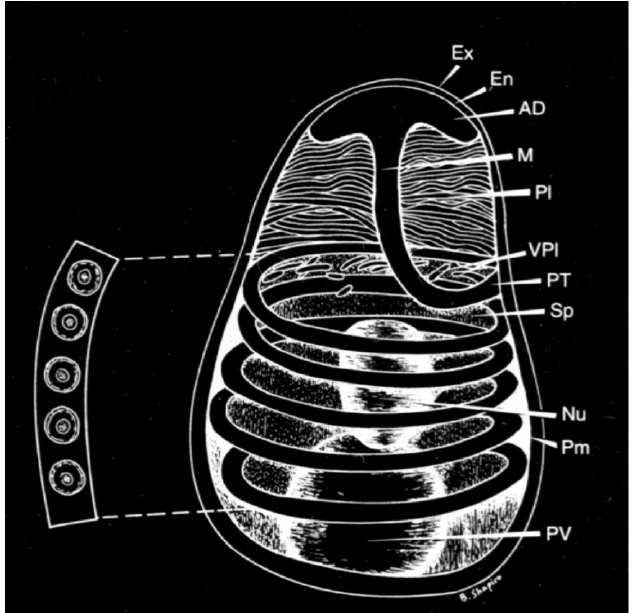
Figure 1. Structure of a spore of Microsporidia. Ex—outer wall of microsporidia spores, En—inner wall of microsporidia spores, AD—top of the spore, M—manubrium, Pl—lamellar polaroplast, VPl—vesicular polaroplast, PT—polar tube, Sp—sporoplasm, Nu—nucleus, Pm—arranged mem- branes, PV—posterior vacuole [22].